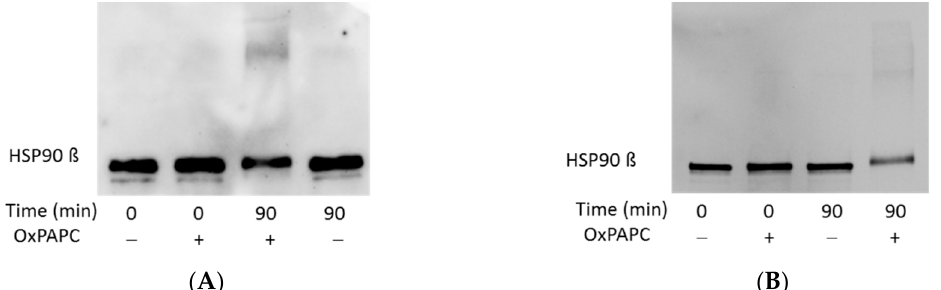
Figure 9. Western blot analysis of HSP90 β from the OxPAPC-treated PBS-soluble fractions from two different preparations ( A , B ). OxPAPC induces a slight band shift of HSP90 β and the generation of high molecular weight protein-OxPAPC complexes. Samples were treated for 0 or 90 min with a final OxPAPC concentration of 0 or 100 µmol/L.